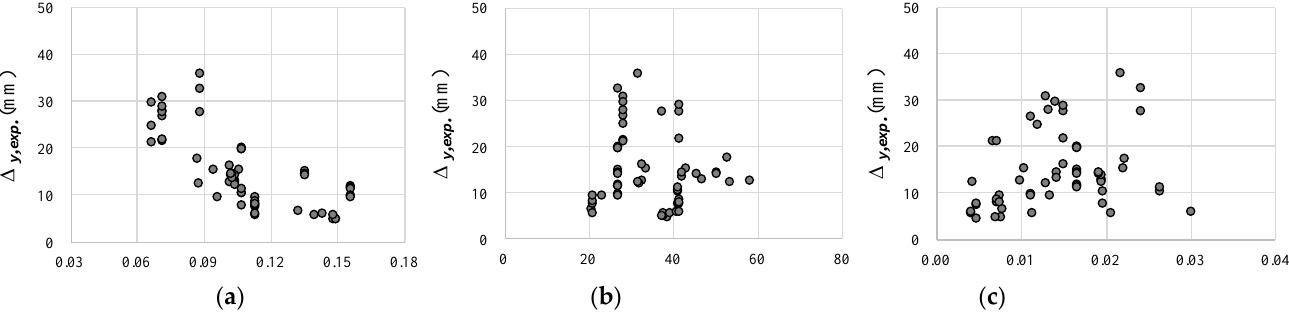
Figure 8. Effect of test variables on deflection at flexural yield: ( a ) d/l ratio; ( b ) concrete compressive strength; ( c ) tension steel ratio.